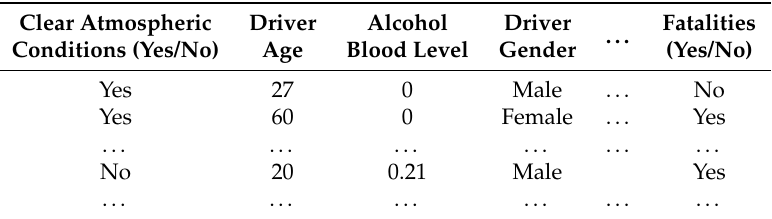
Table 2. An illustration of the adopted car accidents dataset released by the government of the USA through the Fatality Analysis Reporting System (FARS) for the year 2011. It comprises 15 input variables, of which only a selection is shown here, and the corresponding target variable which for the purpose of the present experiment can be considered to be binary valued, taking on the value 1 when there has been a fatality and 0 when